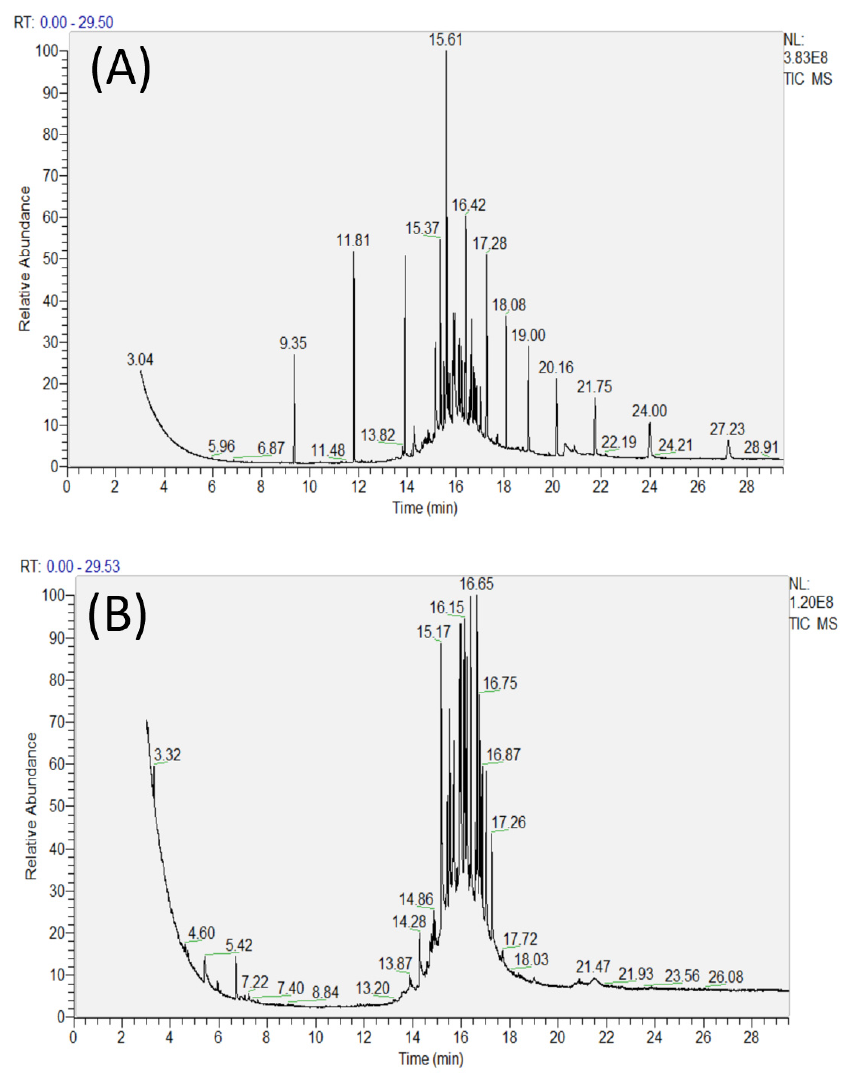
Figure 9. Gas chromatograms of water samples before ( A ) and after ( B ) ozone catalytic treatment.